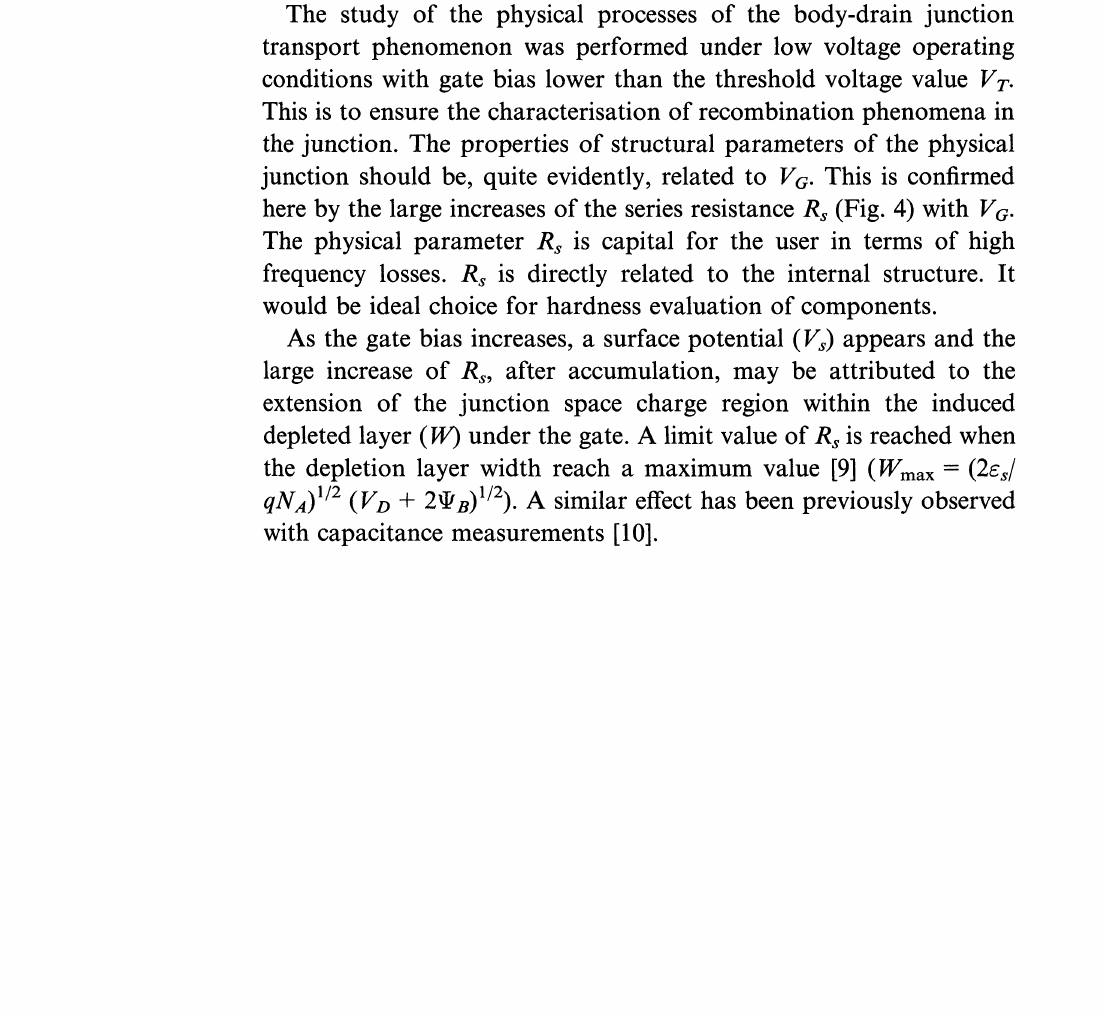
FIGURE 3 Variation ofthe oxide trapped-charge (ANot) and interface (ANit) densities versus total